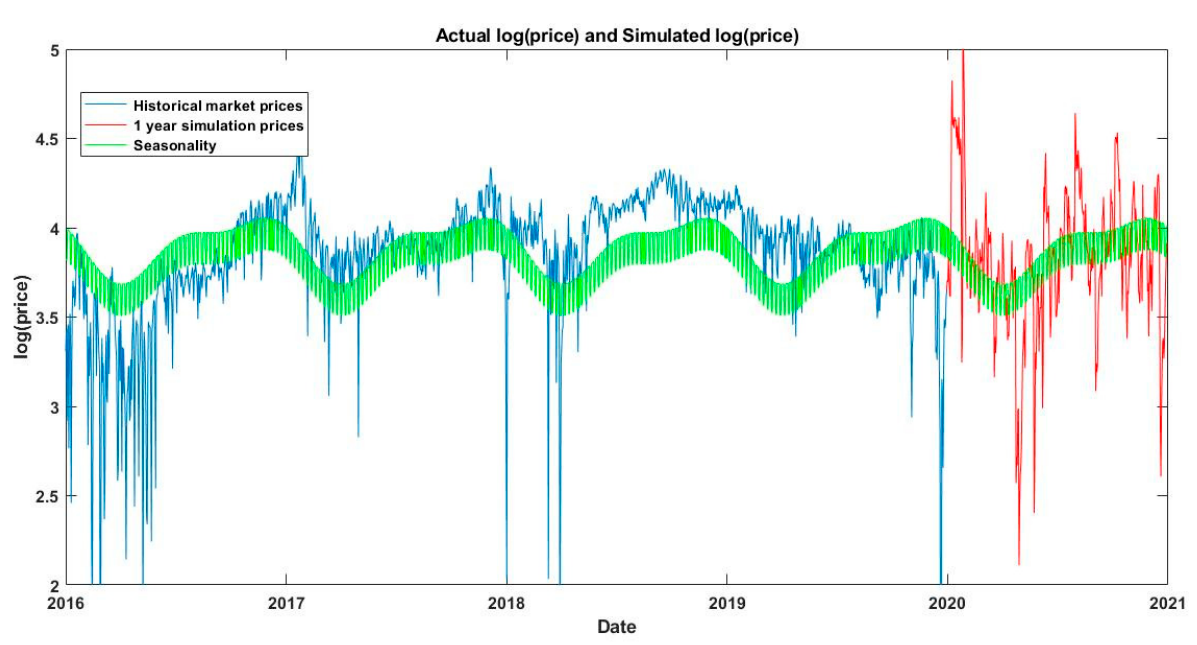
Figure 7. Historic log prices and one simulated path of electricity daily prices.